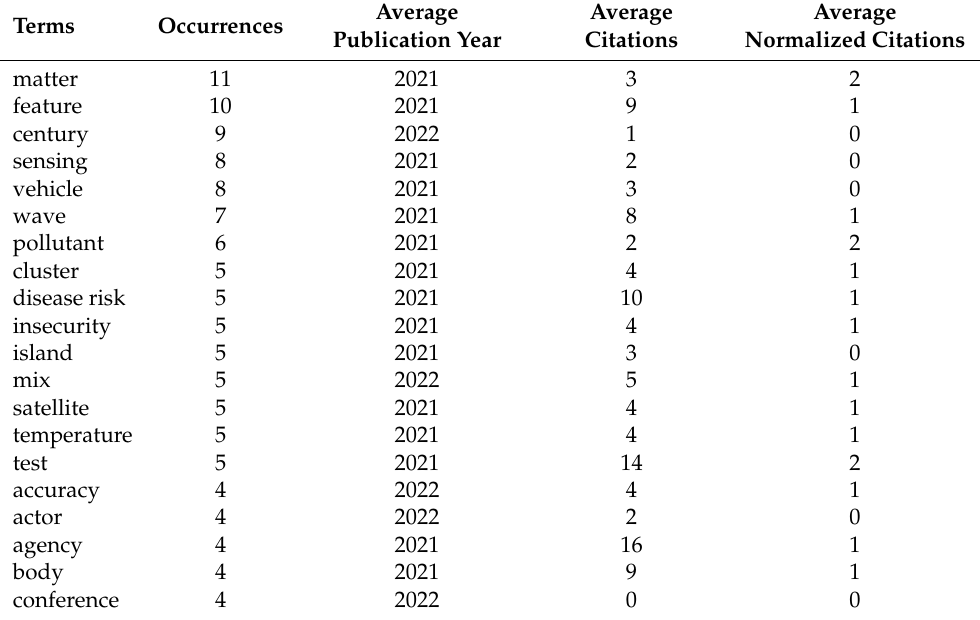
Table 1. Top 20 terms with the highest occurrences found in text data for the topics “COVID-19” and “land use”, applying binary counting with 1 as the minimum number of occurrence of a